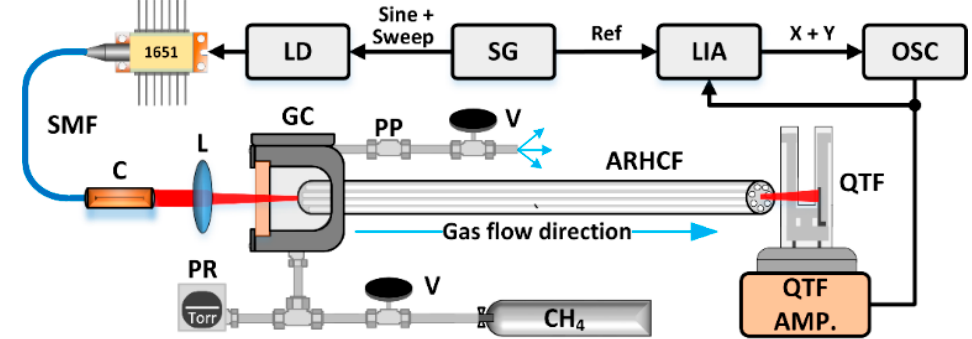
LD—laser driver; SG—signal generator; LIA—lock-in amplifier; OSC—oscilloscope; C—collimator; L—lens; GC—gas cell; PP—purge port; V—valve; PR—pressure readout; QTF AMP.—QTF ampli- fier.